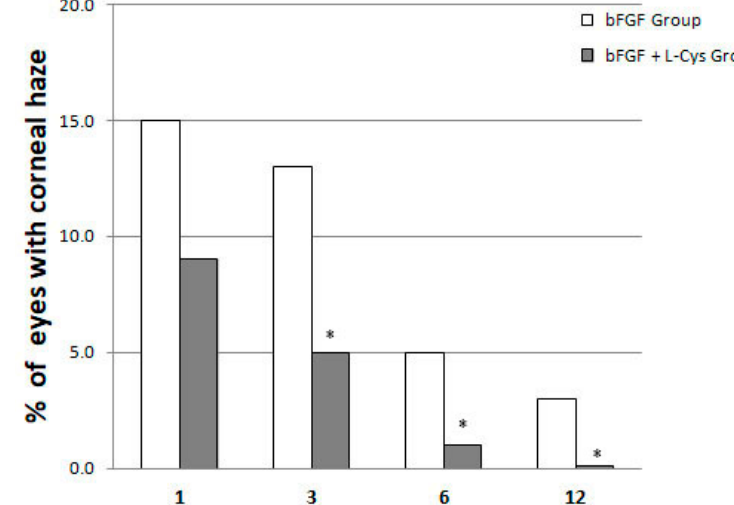
Figure 1. Corneal haze incidence at 3, 6, and 12 month of follow-up as a function of its time of regression in patients who received only bFGF (bFGF Group) and in patients who were administered topical bFGF plus oral L -cysteine supplementation (bFGF + L -cys Group). * p < 0.05 bFGF + L -cys Group vs bFGF Group at each time of follow-up. Pharmaceuticals 2020 , 13 , x FOR PEER REVIEW